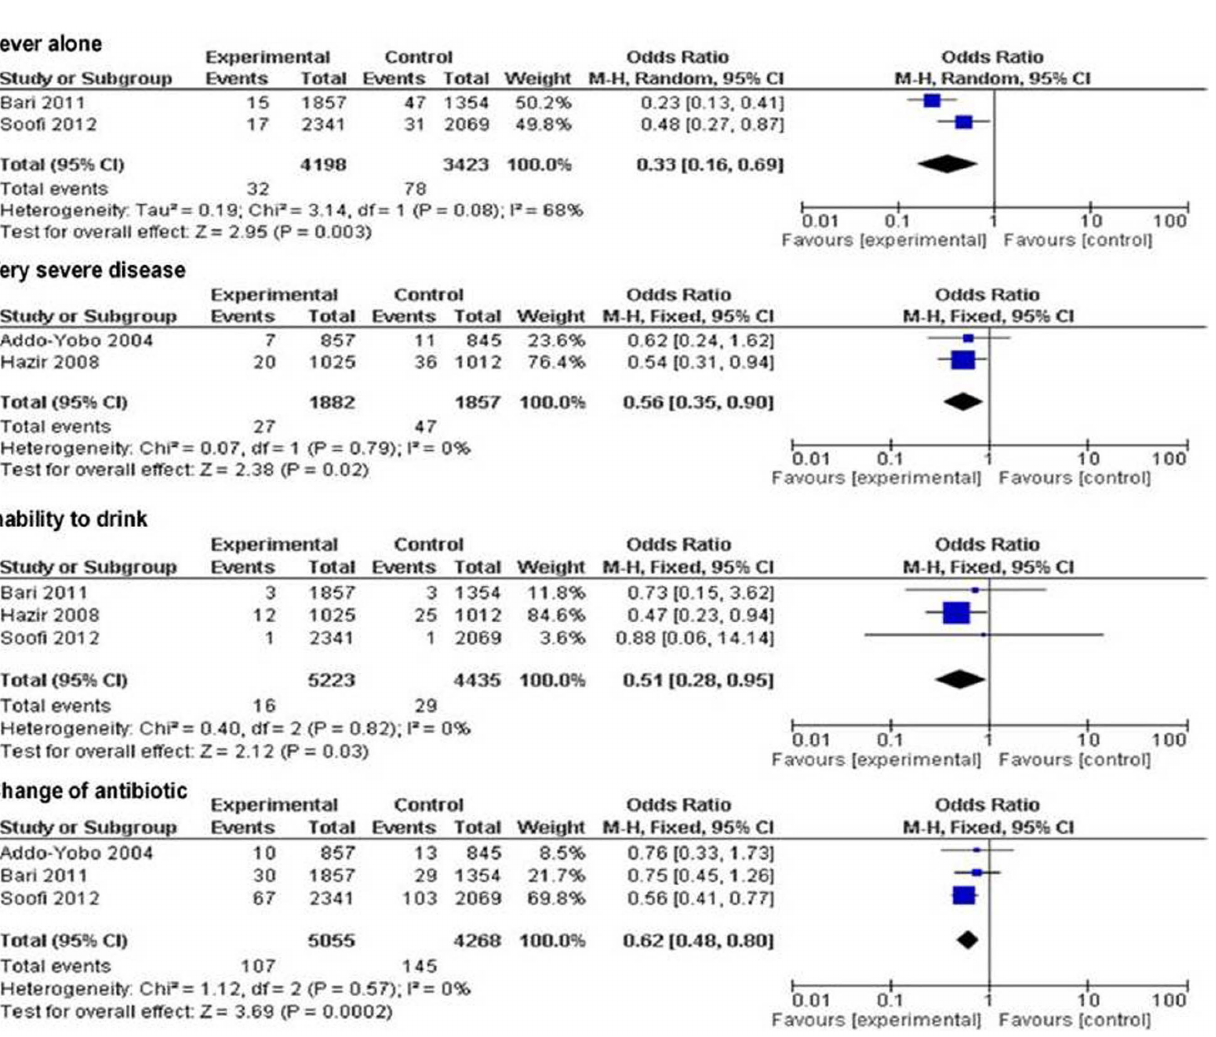
Figure 8. Secondary outcome measures: clinical predictors of treatment failure by day 6.